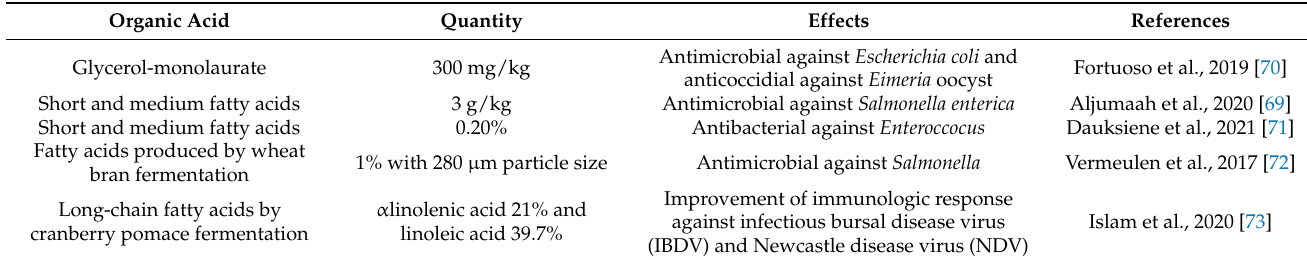
Table 2. Examples of organic acids studied as